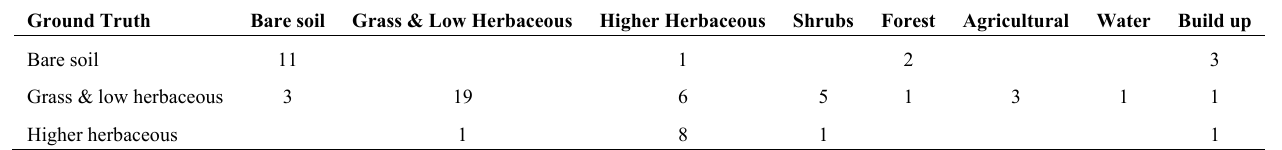
Table 4. Accuracy matrix of CHRIS nadir maximum likelihood